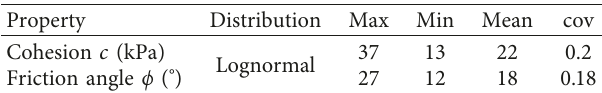
Table 3: Statistical information of the cohesion and friction angle of soil.